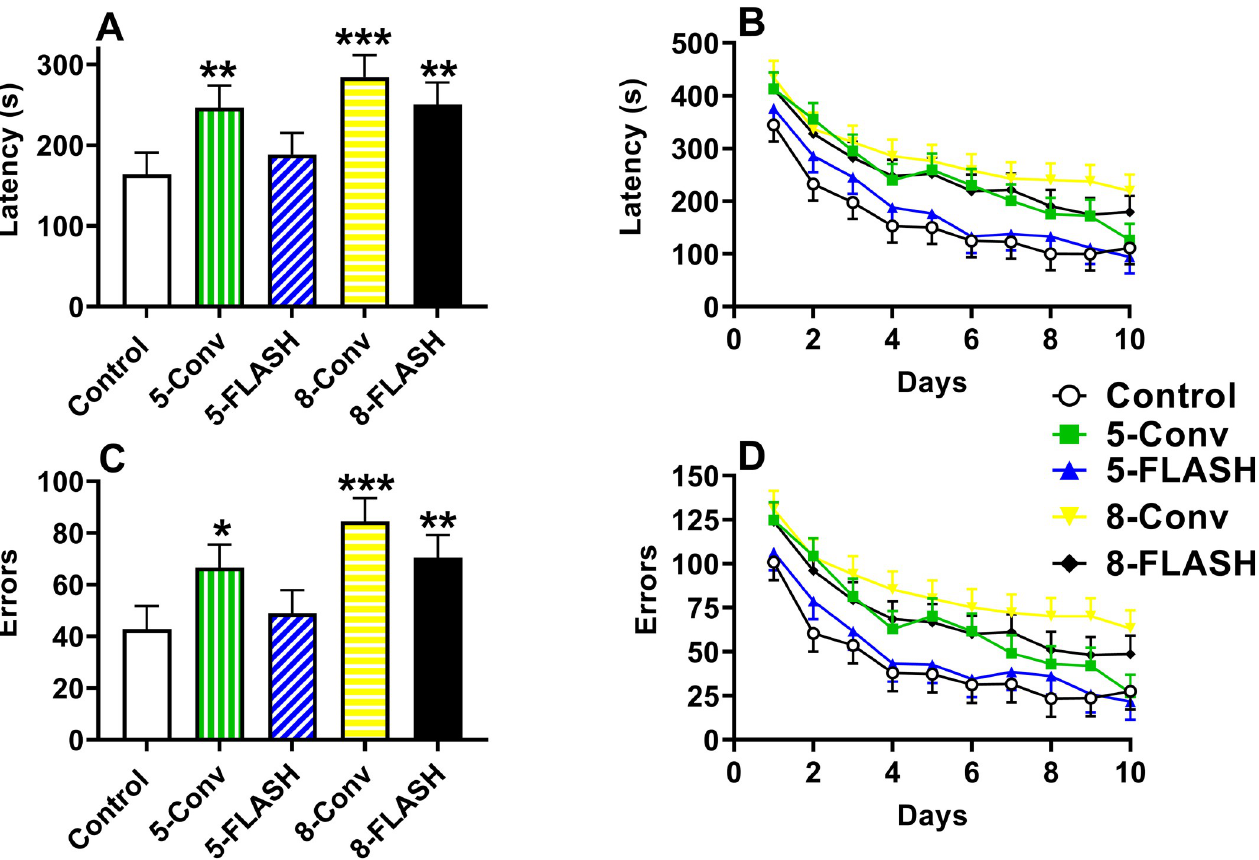
Fig 9. The Cincinnati water maze mirror version latency [s (mean ± SEM)] and number of errors (mean ± SEM) of proton irradiated and control rats. A. The overall effect on latency where irradiated groups with the exception of the 5-FLASH group took longer to locate the platform compared with controls. B. The learning curves for latency. All exposure groups had decreased latencies over days. C. The overall effect on errors where irradiated groups with the exception of the 5-FLASH group had more errors to locate the platform compared with controls. D. The learning curves for errors. Errors decreased over days for all groups. N = 19/sex/exposure except control male and 5-FLASH male = 18. � p < 0.05, �� p < 0.01, and ��� p < 0.001 compared with